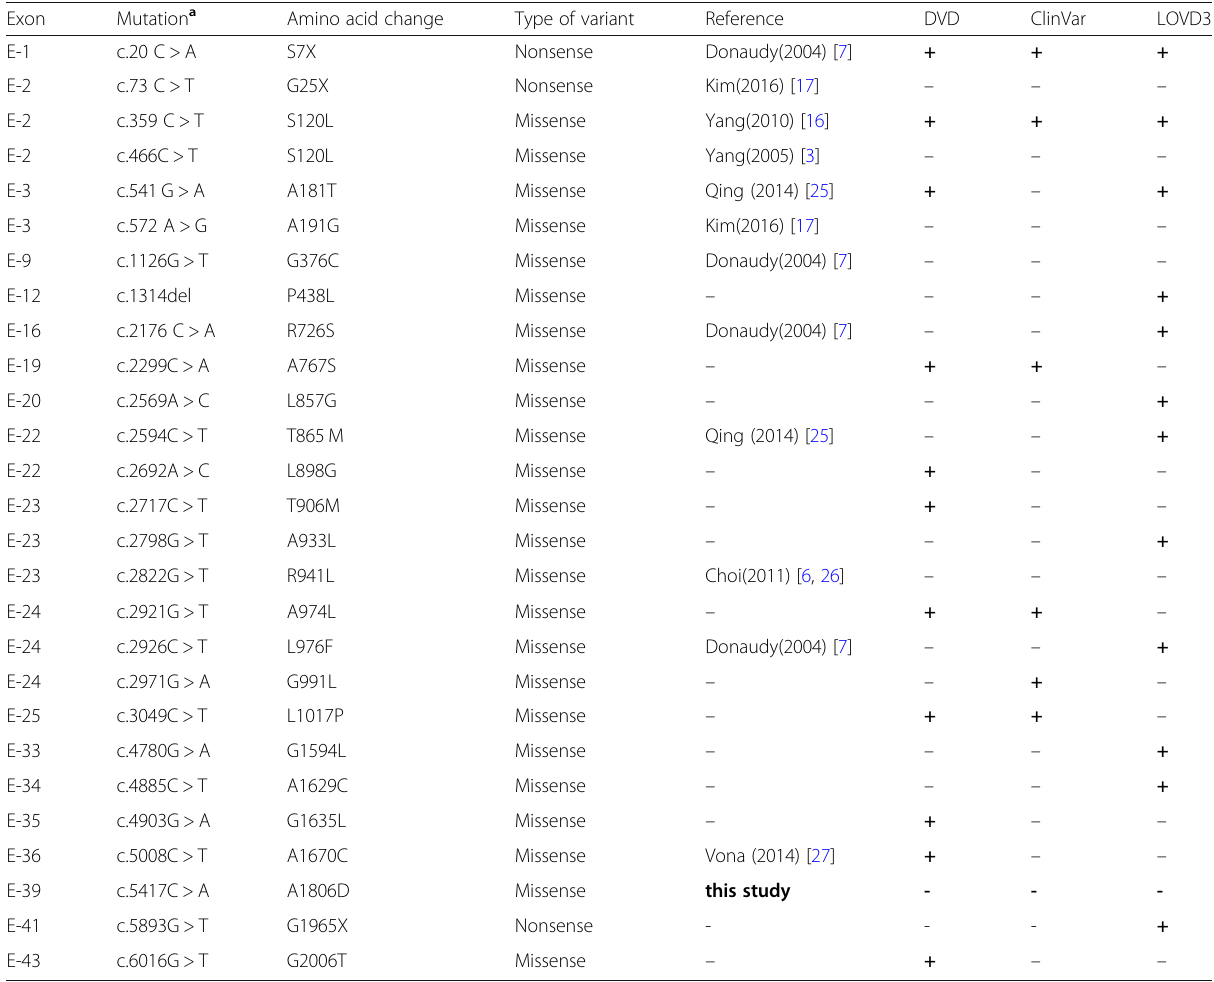
Table 3 MYH14 gene mutations related with sensorineural hearing loss